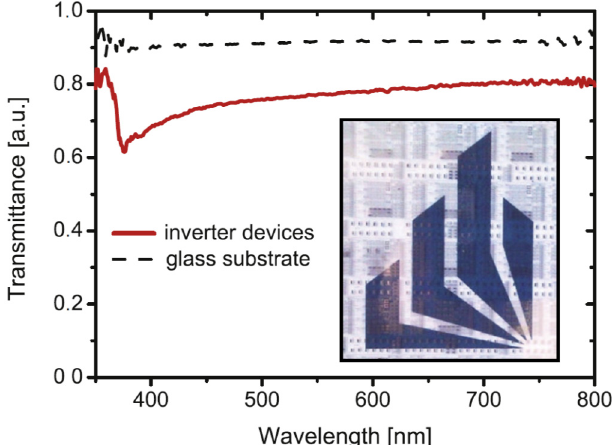
Figure 21. Optical transmittance of ZnO based inverter on a glass substrate. Reprinted from [76], with permission from Elsevier.